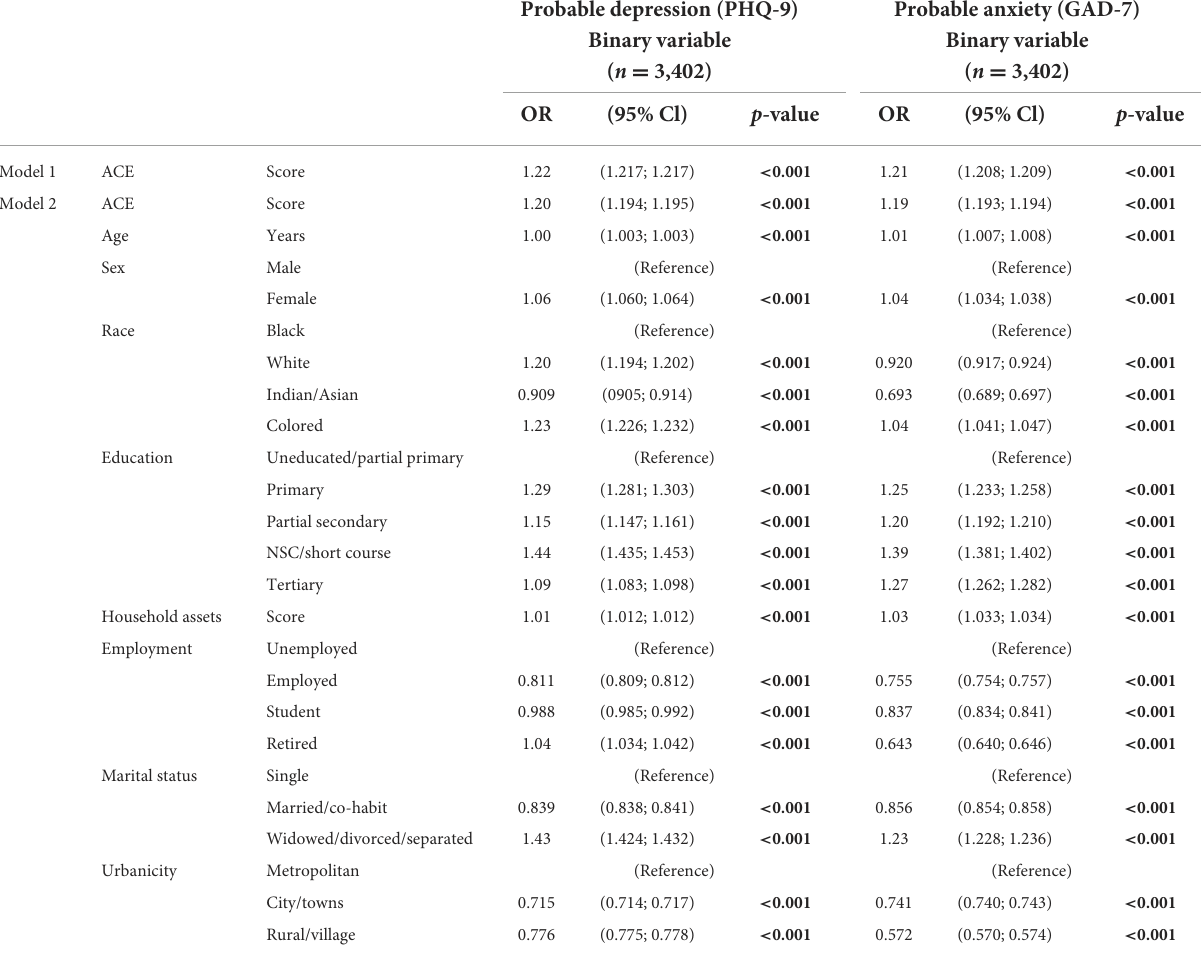
Model1:regressionunadjusted. Model2:regressionadjustedforsocio-demographics. n,numberofparticipants. Boldvaluesdenotestatisticalsignificance(p <